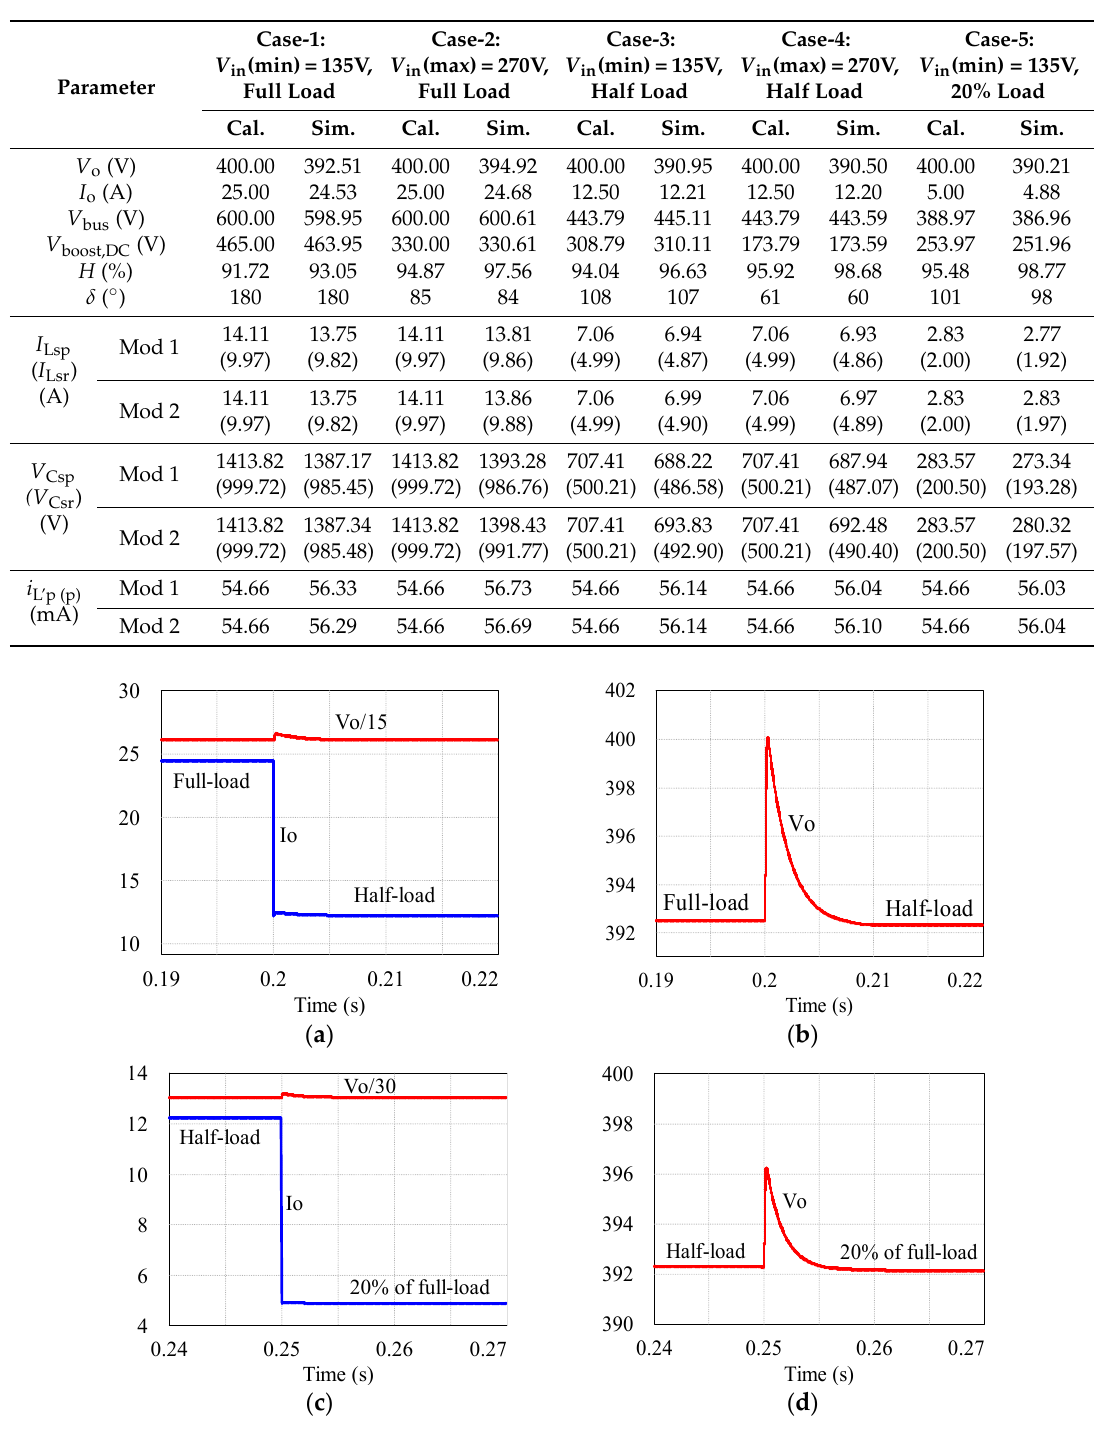
Table 4. Calculation and simulation results [24,33].